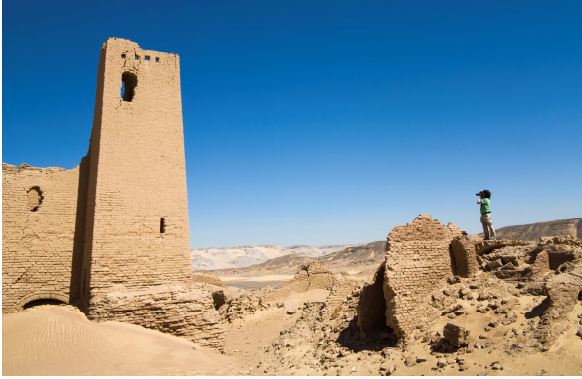
Figure 2. The photogrammteric survey of the castle